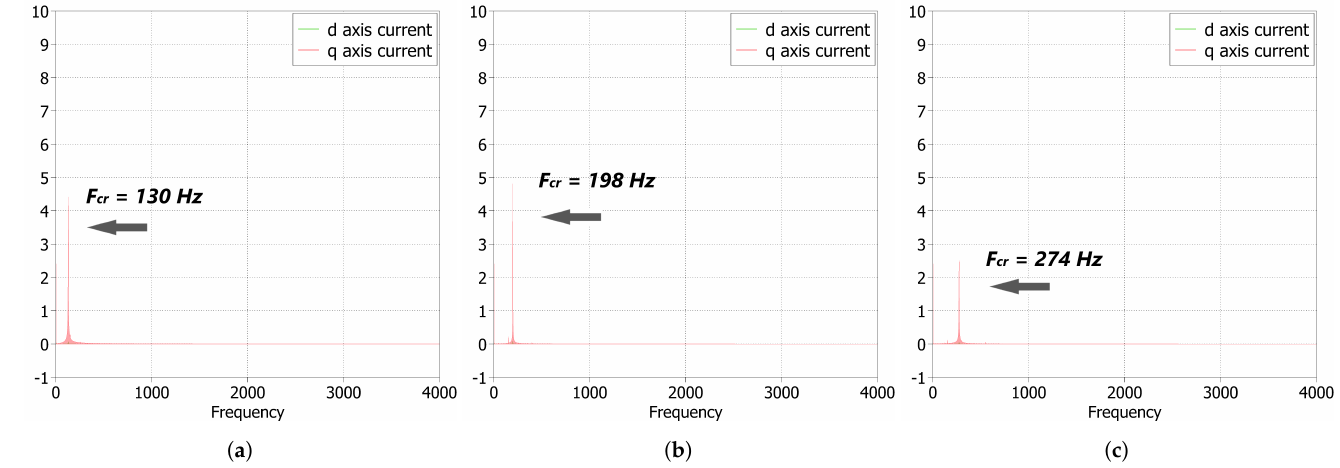
Figure 21. FFT analysis of the VSC inductor current I L for different AVC filter cases in the strong grid (SCR = 10). The dominant oscillation frequency is shown when K I , a obtains its critical value; ( a ) f AVC,LPF = 20 Hz; ( b ) f AVC,LPF = 50 Hz; ( c ) f AVC,LPF = 100